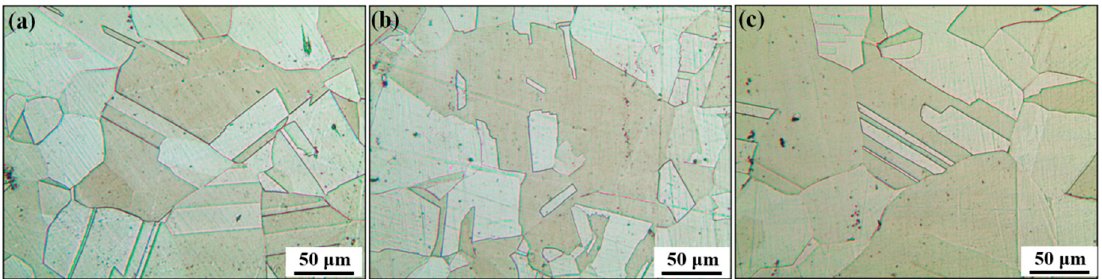
Figure 3. Equilibrium phase diagrams of new alumina-forming austenitic heat-resistant steels: ( a ) 1.5Al; ( b ) 2.5Al; ( c ) 3.5Al. Table 1. Chemical compositions of the new alumina-forming austenitic heat-resistant steels (wt. %). Alloy